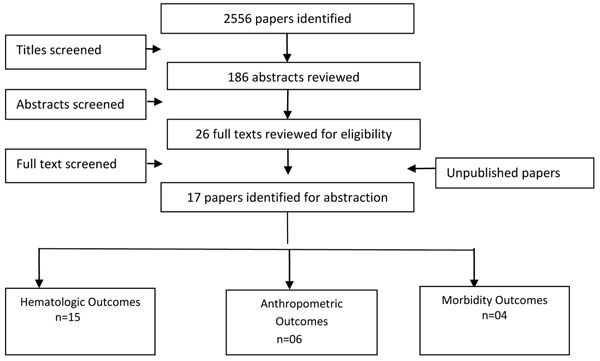
Search Flow Diagram